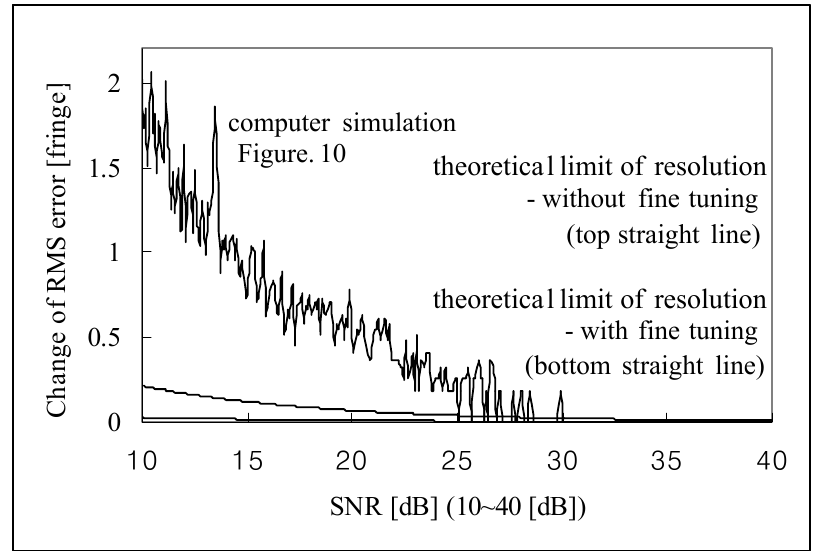
Figure 16 . Comparison of computer simulation and theoretical limit ( SNR : 10-40 [dB]).